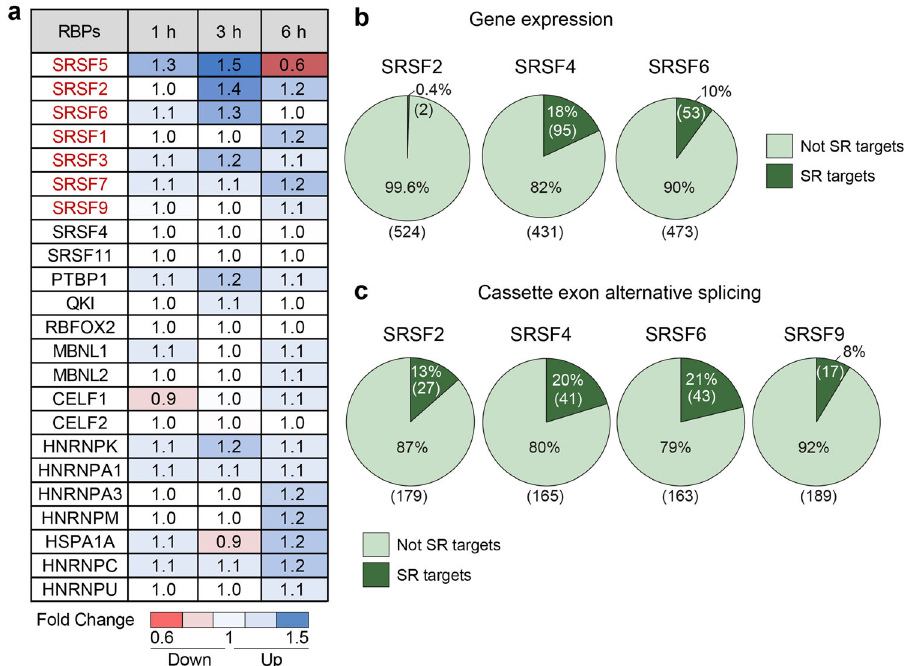
Fig. 6 A portion of the genes that are mechanosensitive are targets of the SR proteins. a Gene expression changes of various RNA-binding proteins (RBPs) upon cell stretching of differentiated cells. The fold change was de fi ned as the ratio between stretched and non-stretched samples. Values above 1 indicate upregulated genes and values below 1 indicate downregulated genes. b Pie charts exhibiting the overlap between genes that respond to SR protein overexpression at the transcriptional level 43 and genes that respond to cell stretching. The numbers between parentheses indicate the number of genes. c Pie charts showing the overlap between genes with alternative cassette exons that respond to SR protein overexpression 43 and genes with alternative cassette exons that respond to cell stretching (splicing level). The numbers between parentheses indicate the number of